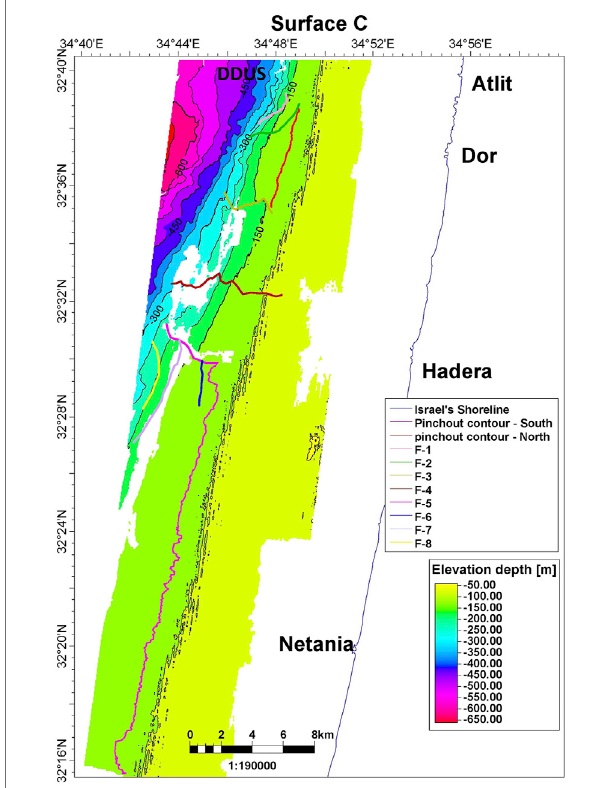
FIGURE 7 | Seismic mapping of Horizon C.